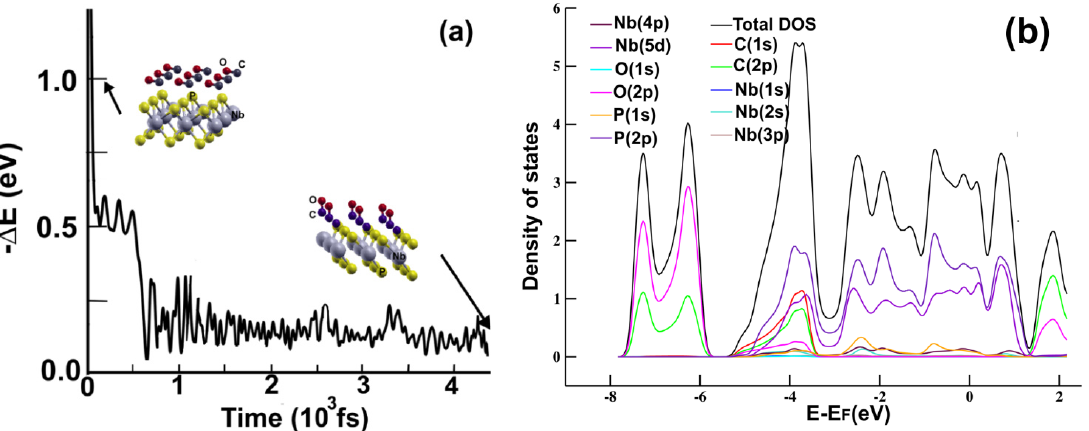
Figure 4. ( a ) The time evolution of the system’s energy from our FPMD simulation at atmospheric pressure and 300 K for the CO adsorption on the 2D NbP 2 surface. The adsorption energy is − 0.9017 eV. The final distance from the carbon atom to the plane is 1.3277 Å; ( b ) PDOS for the carbon mon- oxide molecule adsorbed on the 2D NbP 2